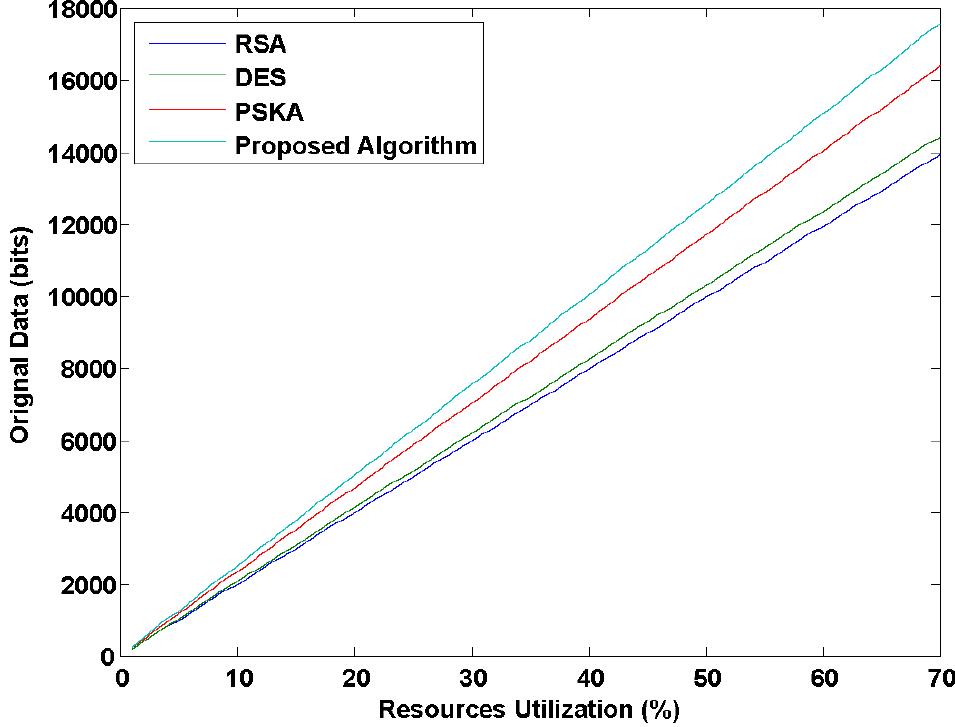
Figure 6. Amount of data transmission in bits with same percentage of resource utilization for different